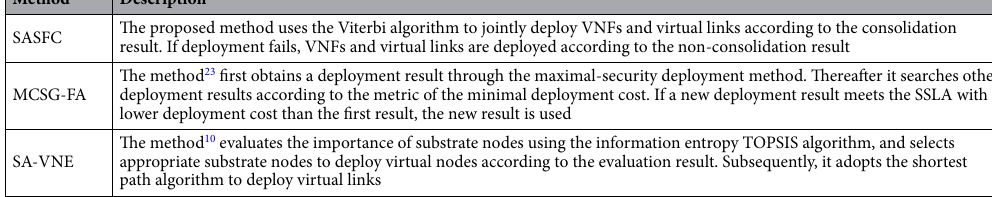
Table 1. Description of the three